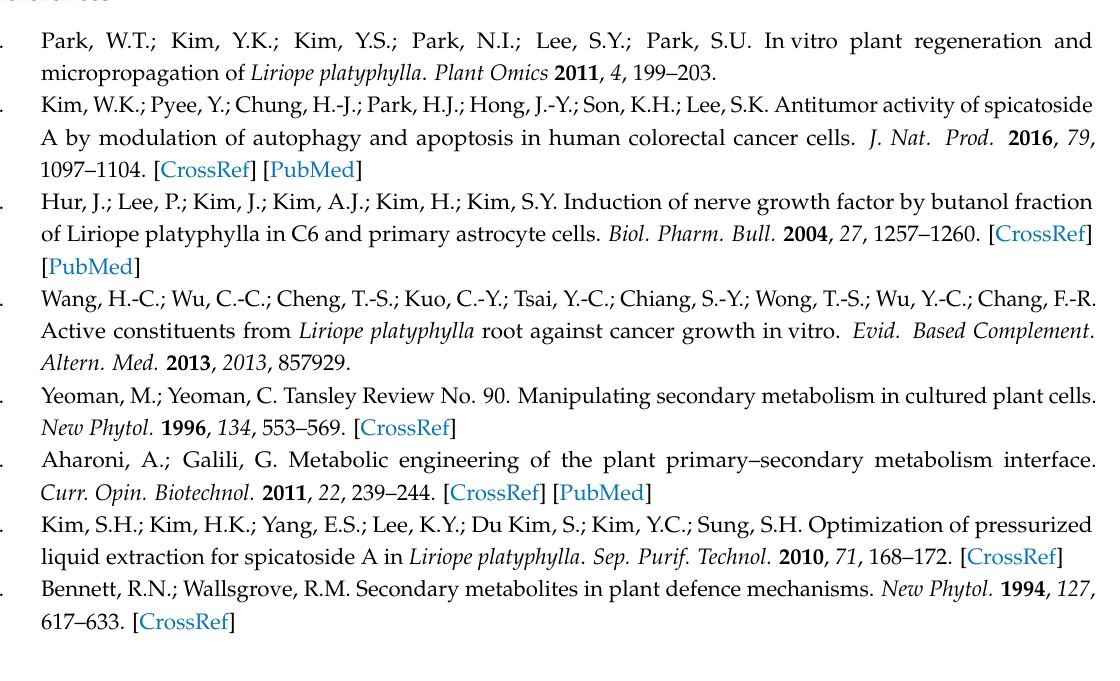
Table S1: Metabolite peak height differences using GS–TOFMS; Table S2: Metabolites identified in GC–TOFMS chromatograms of Liriope platyphylla ; Table S3: The raw data of metabolites obtained from Liriope platyphylla using GC–TOFMS. Figure S1: The chromatogram of metabolites obtained from Liriope platyphylla (Cheongyangjaerae) using GC–TOFMS. Peak identification: 1, pyruvic acid; 2, lactic acid; 3, alanine; 4, glycolic acid; 5, valine; 6, serine; 7, ethanolamine; 8, glycerol; 9, leucine; 10, isoleucine; 11, proline; 12, nicotinic acid; 13, glycine; 14, succinic acid; 15, glyceric acid; 16, fumaric acid; 17, threonine; 18, β -alanine; 19, malic acid; 20, aspartic acid; 21, pyroglutamic acid; 22, 4-aminobutyric acid; 23, threonic acid; 24, arginine; 25, glutamic acid; 26, phenylalanine; 27, p-hydroxybenzoic acid; 28, xylose; 29, asparagine; 30, vanillic acid; 31, glutamine; 32, shikimic acid; 33, citric acid; 34, quinic acid; 35, fructose; 36, galactose; 37, glucose; 38, mannose; 39, mannitol; 40, p-coumaric acid; 41, inositol; 42, ferulic acid; 43, tryptophan; 44, sinapic acid; 45, sucrose; 46, trehalose; 47, raffinose; IS, internal standard